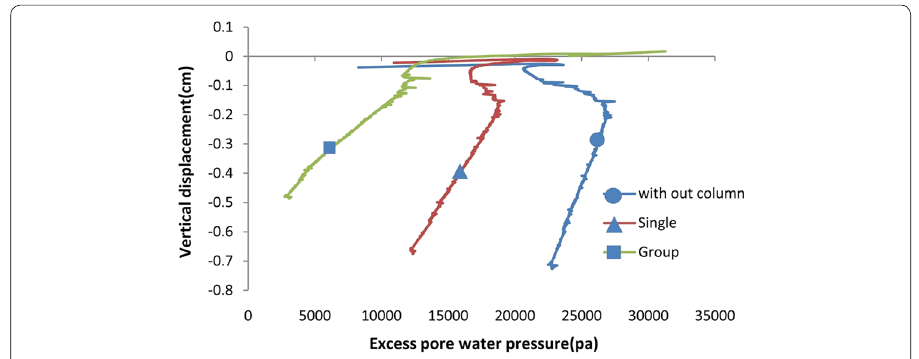
Fig. 22 Changes of vertical displacement against excess pore